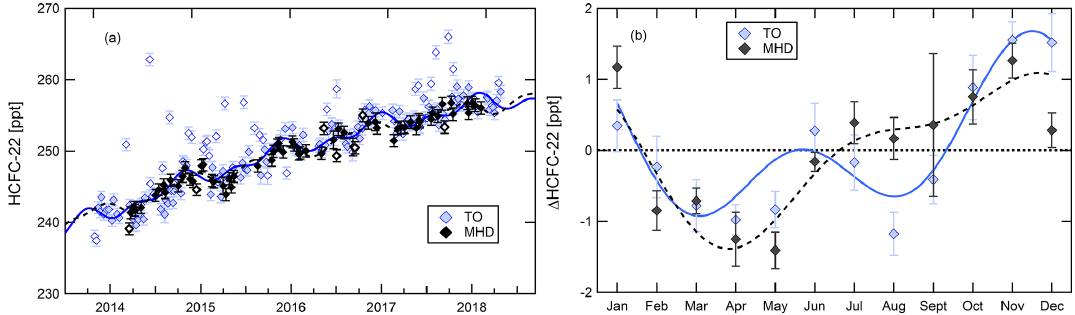
Figure 6. Time series (a) and seasonality (b) of HCFC-22 at Taunus Observatory (blue) and at Mace Head (black). Open symbols in the time series indicate samples flagged as outliers. Seasonality is shown as the difference of the monthly mean to the mean of the full detrended baseline time series.